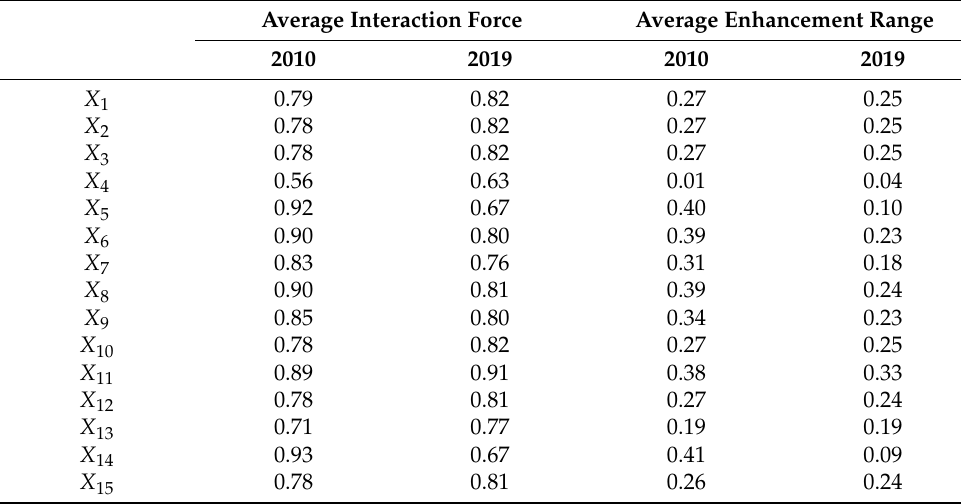
Table 6. Average interaction force and enhancement range in the YRD.